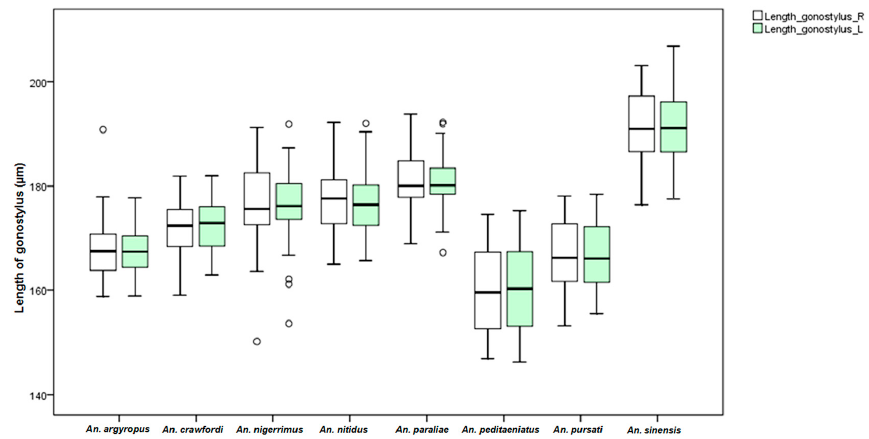
Figure 12. The Box-and-Whisker Plots representation of variation in gonocoxite length of adult male of the eight Hyrcanus Group species.